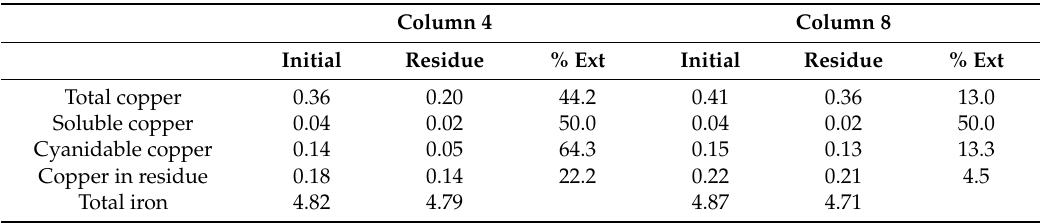
Table 10. Copper extractions in column 4 (32.9 ◦ C, 0.6 kg H 2 SO 4 /50 kg of ore, 0.525 kg NaCl/50 kg of